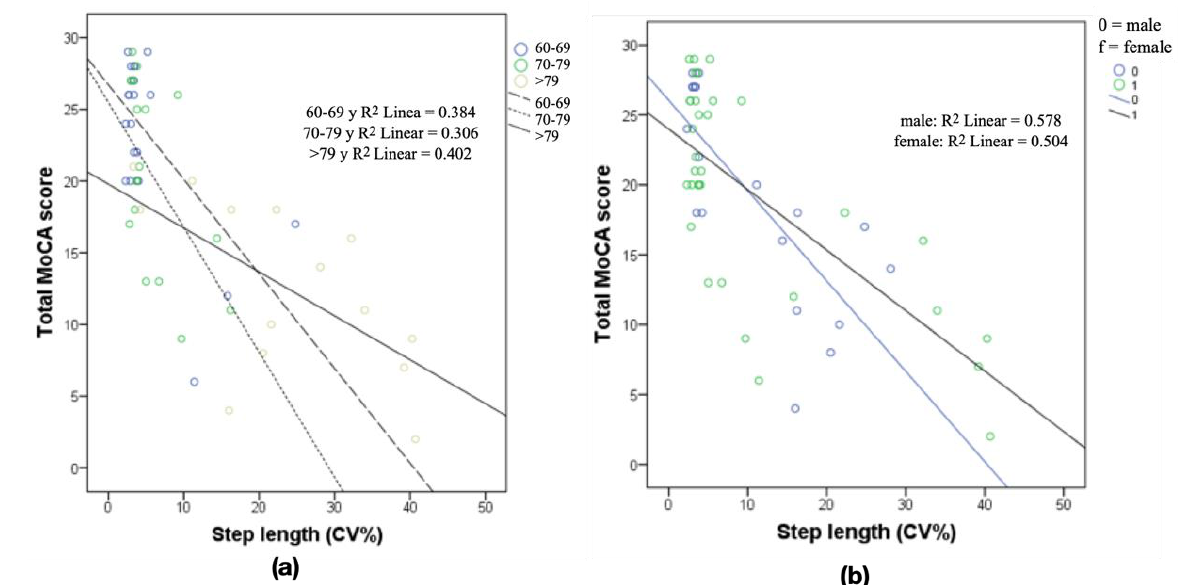
Figure 2. ( a ) Simple regression analysis relating CV step length and MoCA score in the three age groups and ( b ) CV step length and MoCA score in relation to the sex of the participants. R 2 , Pearson correlation.